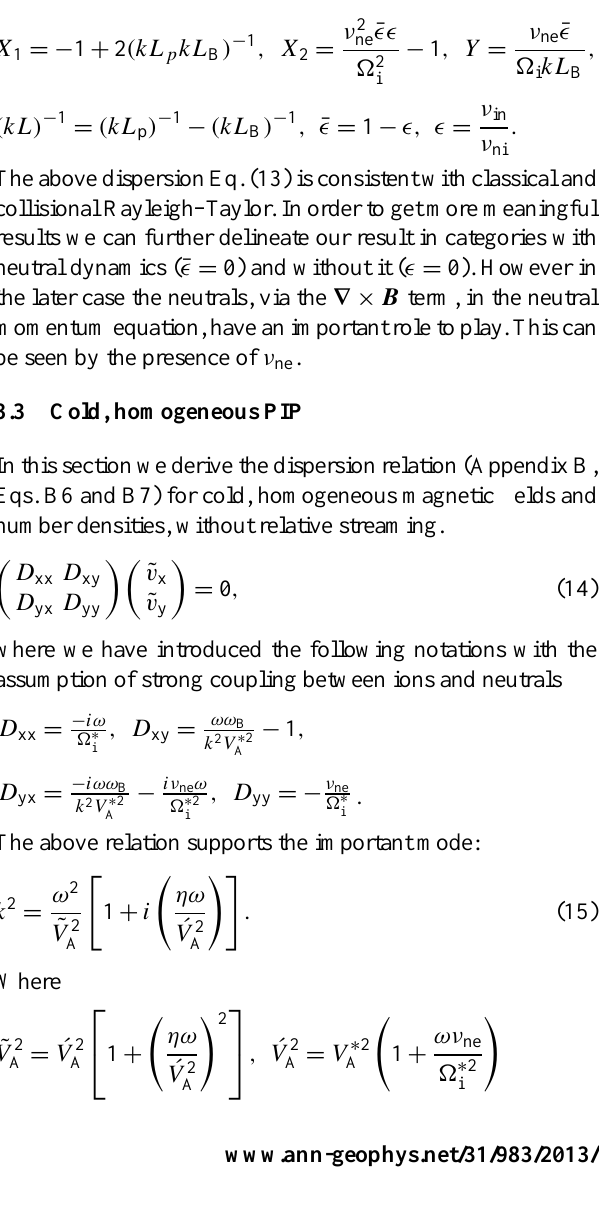
these regions. The above reported instability is on-set by rel-